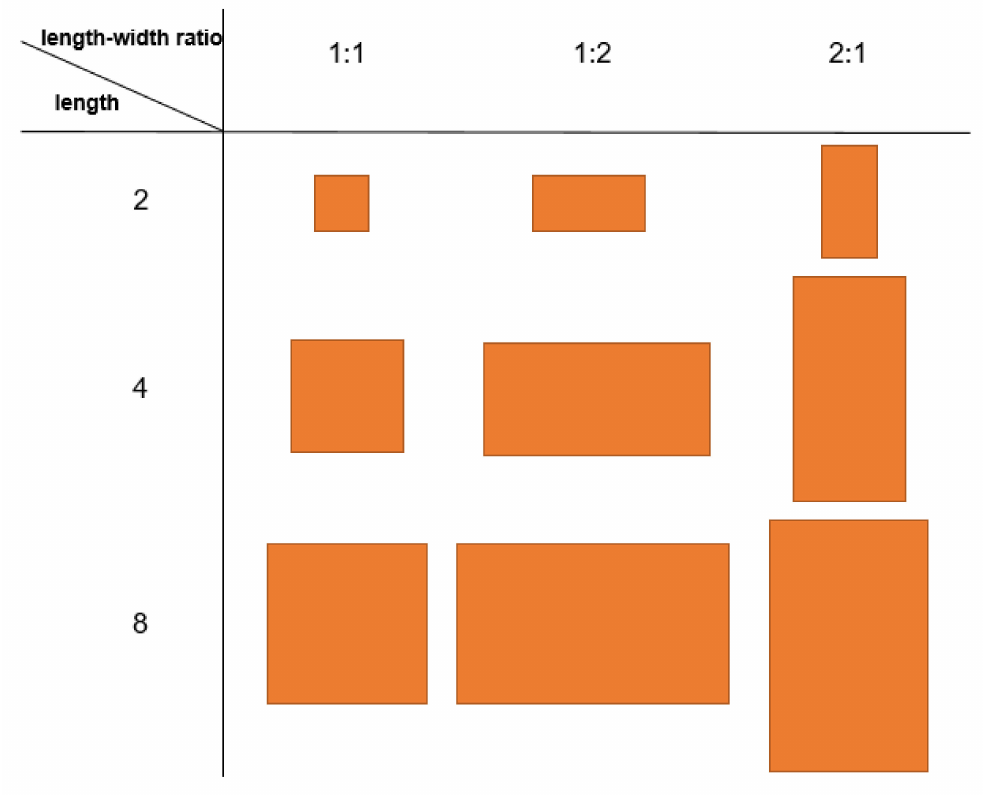
Figure 4. Nine kinds of anchor improved for small target detection in the Unmanned Aerial Vehicle (UAV) remote sensing